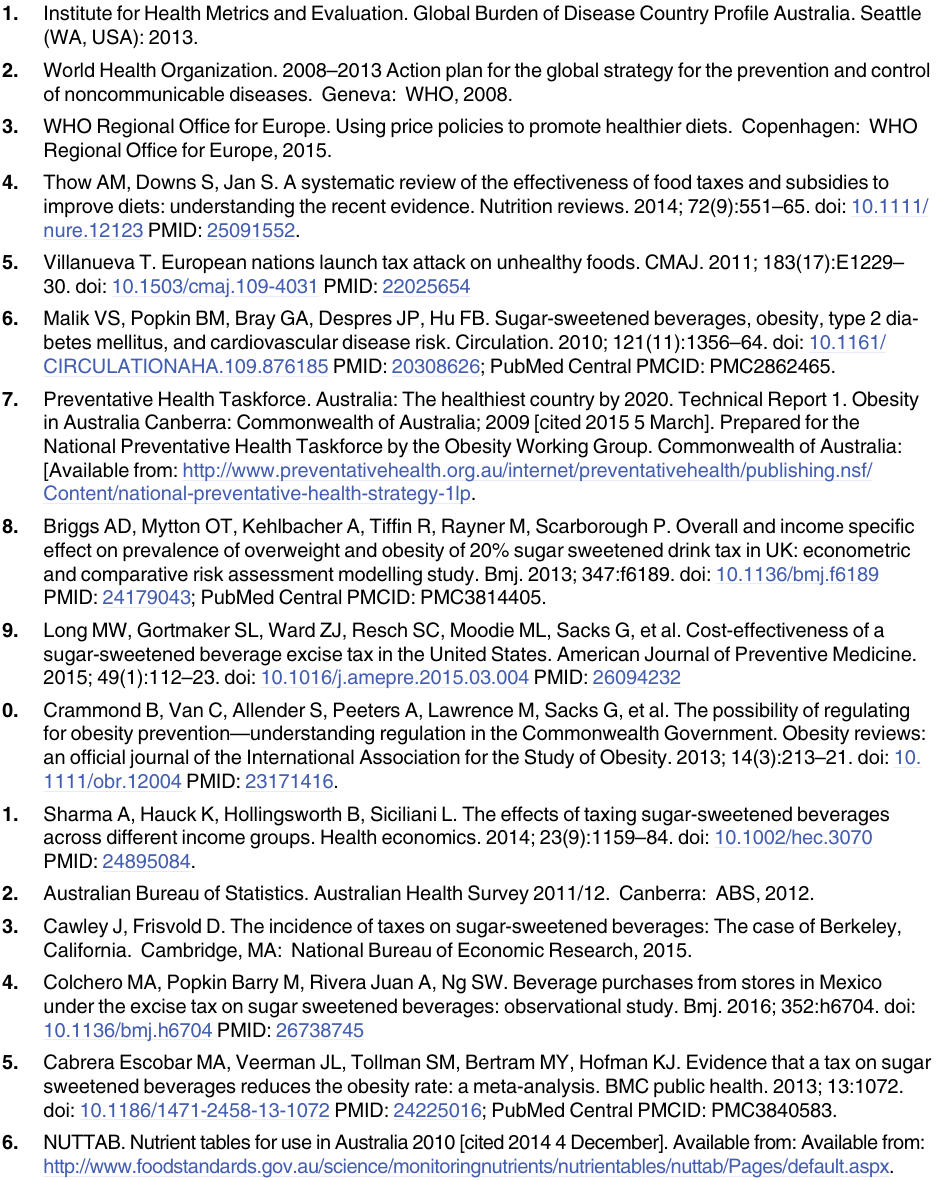
S2 Table. Relative risks of disease per 1 unit increase of BMI. (PDF) S3 Table. Results of nine diseases over the first 25 years after the introduction of the tax.